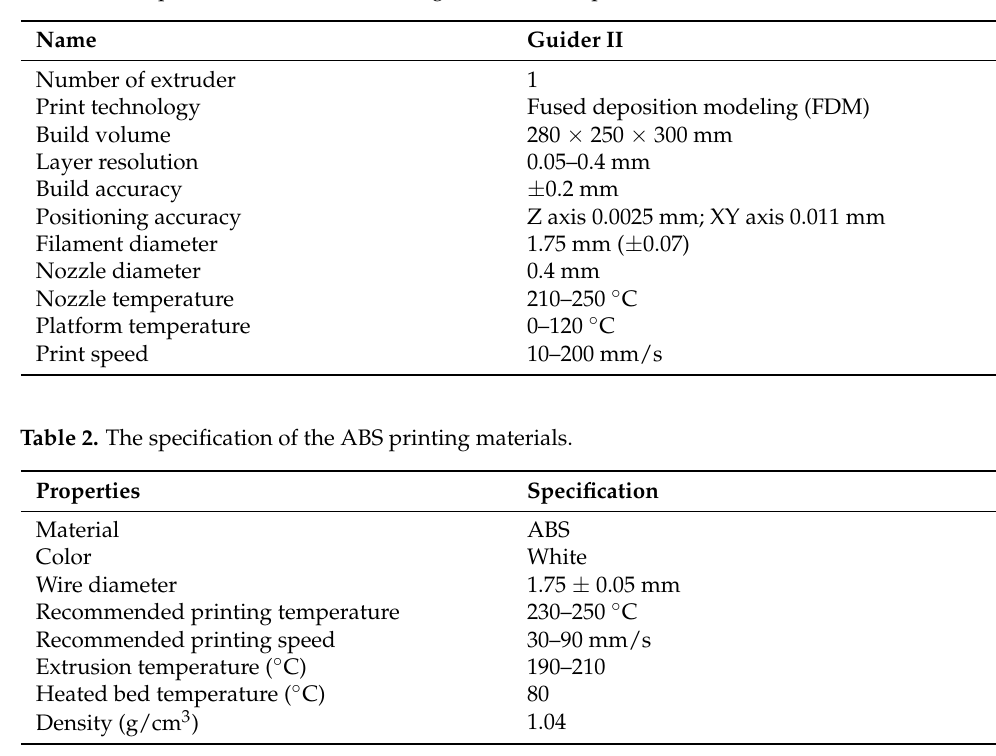
Table 1. The specification of the Flash Forge Guider II 3D printer.